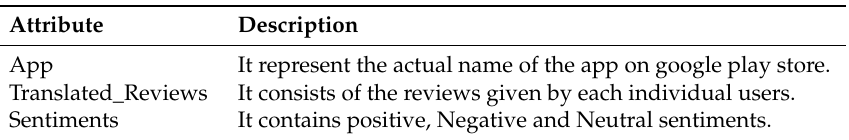
Table 1. Descripton of dataset